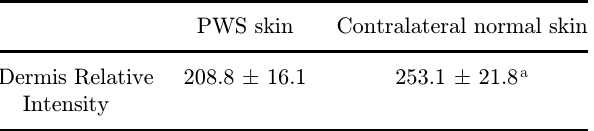
Table 1. Dermis relative intensity measurements of PWS skin and contralateral normal skin. PWS skin Contralateral normal skin Dermis Relative 208.8 (cid:7) 16.1 253.1 (cid:7) 21.8 a Intensity a p < 0 : 01.